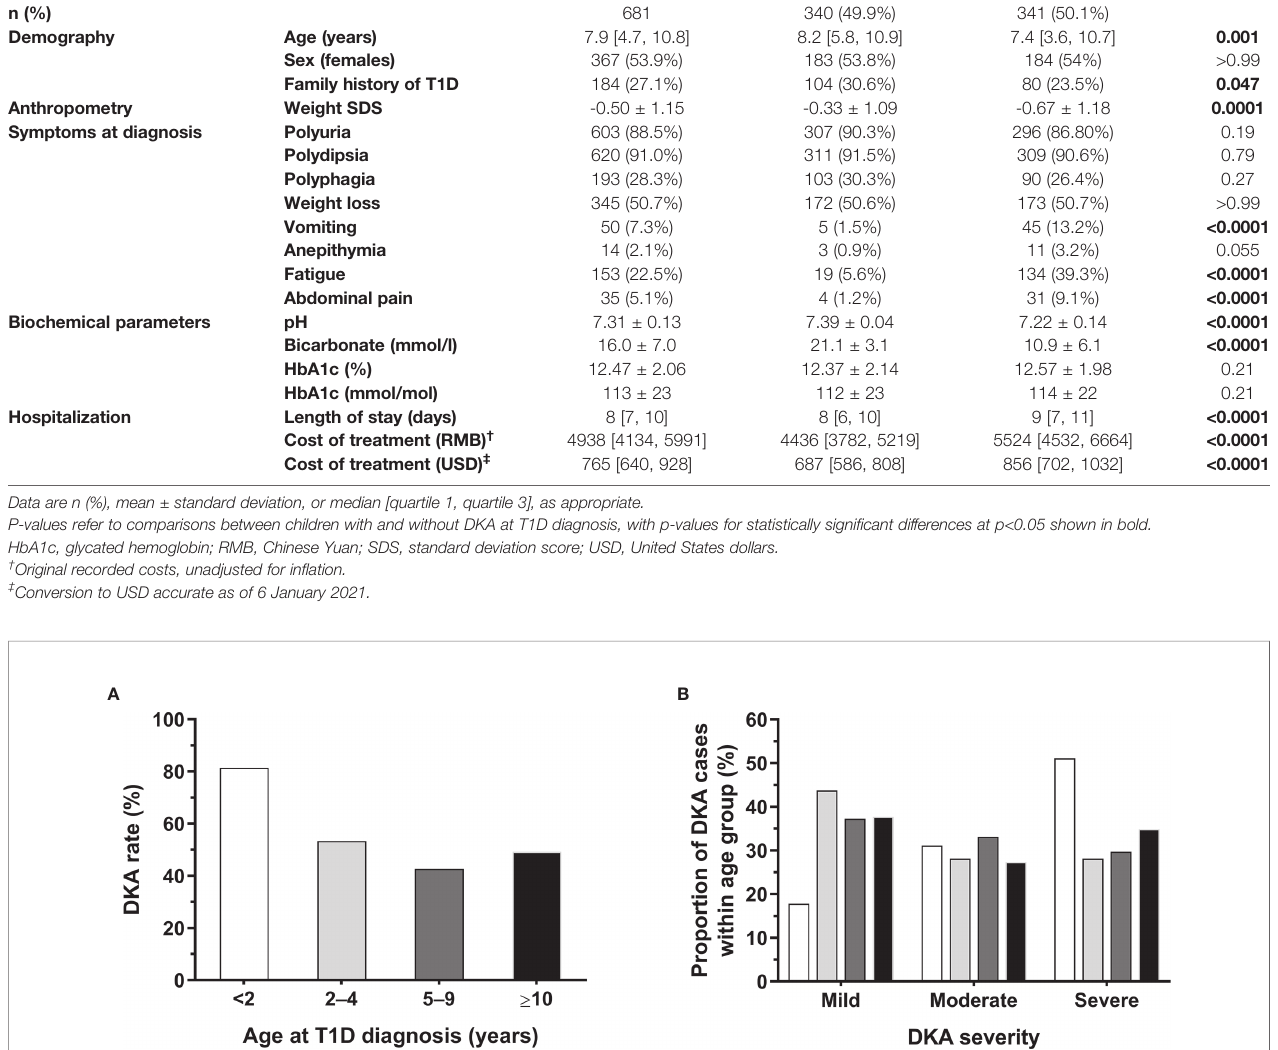
TABLE 1 | Demographic and clinical data at type 1 diabetes (T1D) diagnosis in children and adolescents at the Children ’ s Hospital of Zhejiang University School of Medicine (Hangzhou, China), according to their diabetic ketoacidosis (DKA) status. All patients No DKA DKA